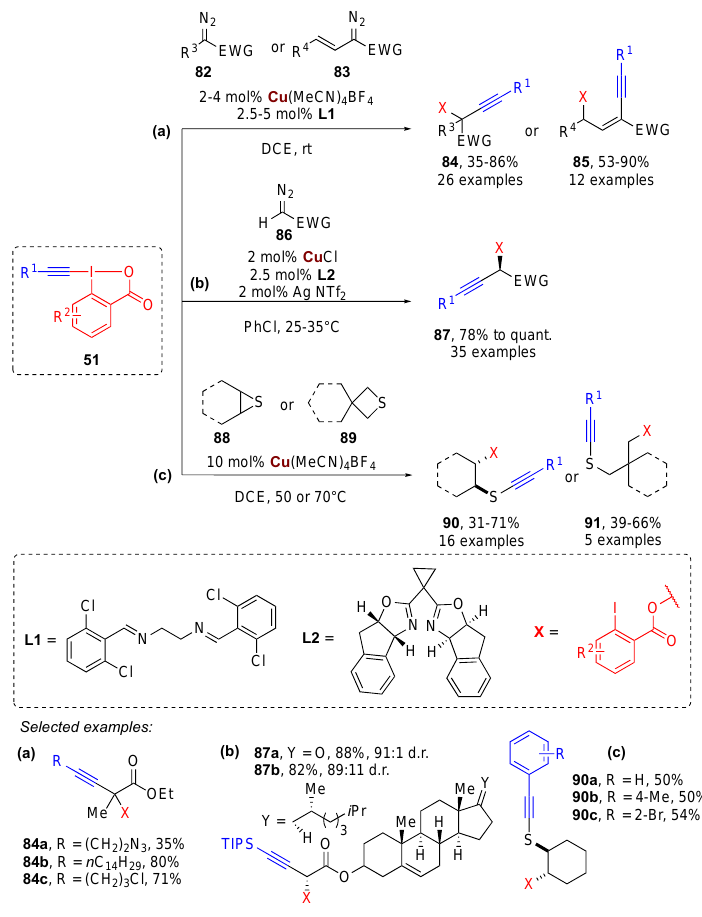
Scheme 18. Copper-catalyzed oxyalkynylation reactions with the use of EBXs 51 . See explanation of reactions ( a – c ) in the text. Selected examples of products obtained in the reactions ( a – c ) are shown at the bottom of the scheme.